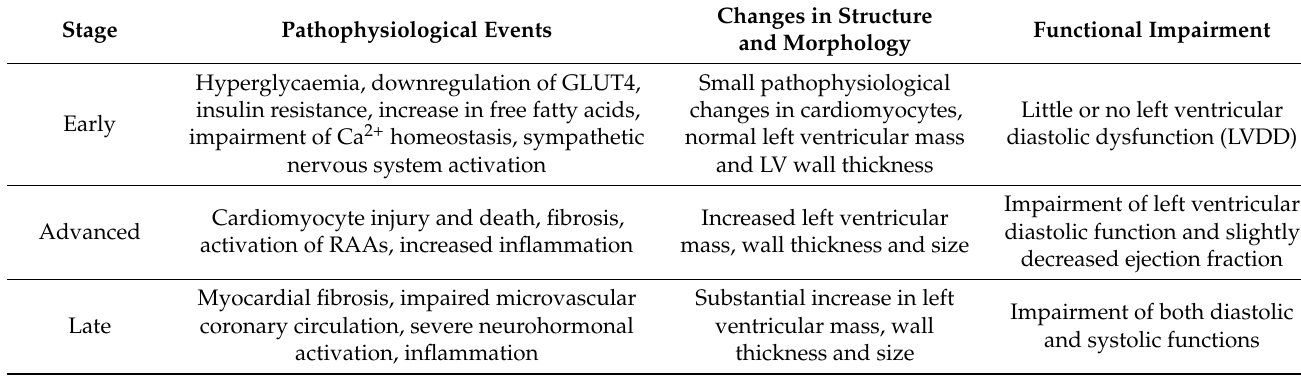
Table 1. Progression of